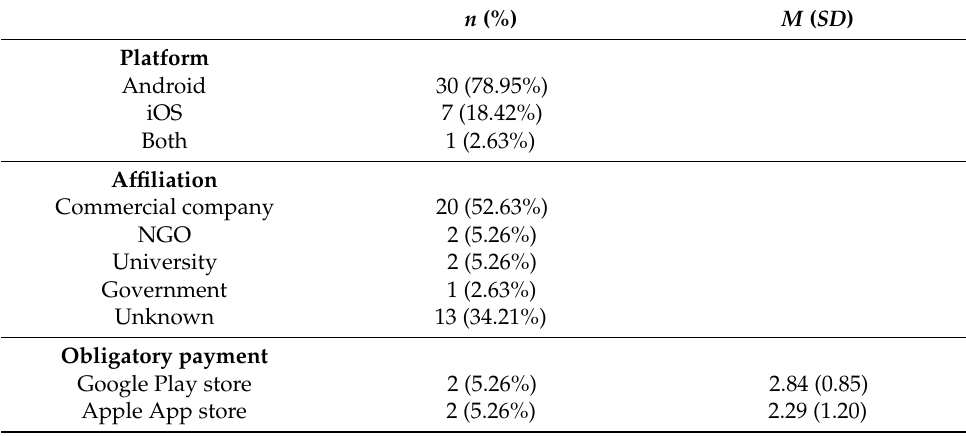
Figure 1. Flowchart of the app screening and inclusion process. Table 1. General characteristics of included MHA for coronary heart disease. n